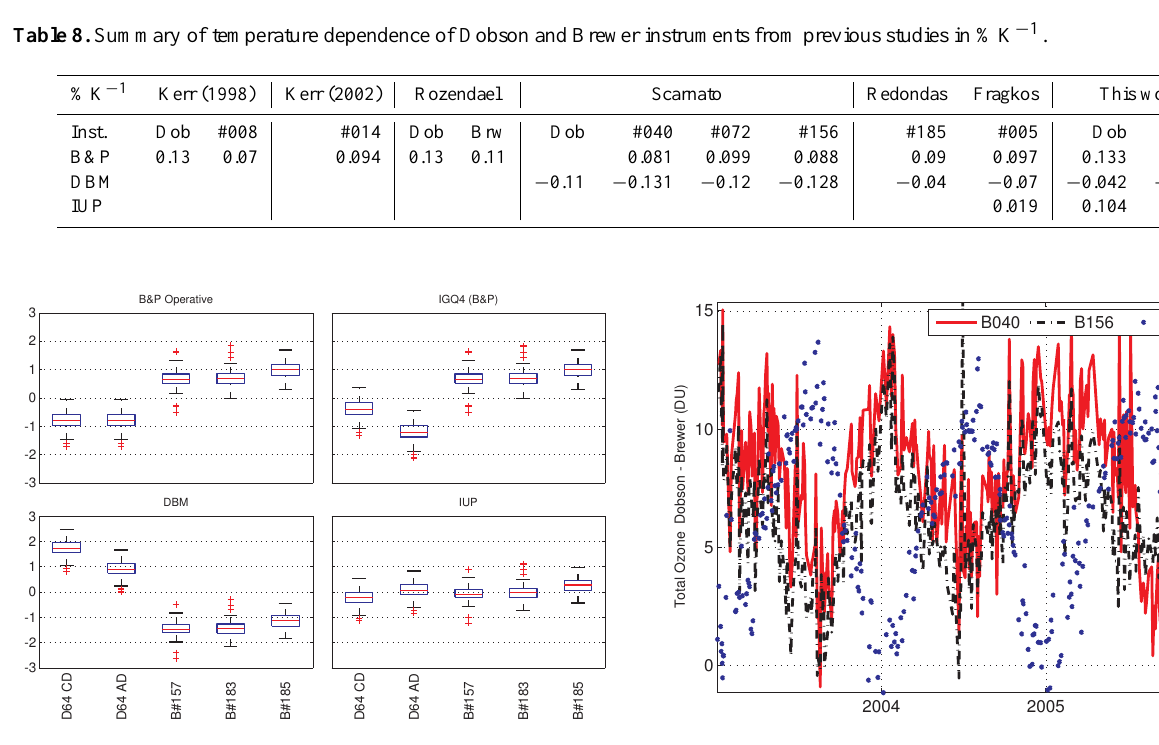
Fig. 8. Box plot of the percentage differences versus the mean of Dobson and Brewer instruments during the 2012 Langley plot cal- ibration campaign at Izaña Observatory for four cross sections: (1) Bass & Paur Operative (BOp); (2) Bass & Paur from quadratic co- efficients (IGQ4); (3) Daumont, Brion and Malicet (DBM); and (4) the University of Bremen (IUP). The first two boxes in each panel correspond to the Dobson pairs CD and AD and the last three to the Brewer triplet used at the RBCC-E. Table 9. Coefficients used to convert the ozone operational observa- tions of Dobson and Brewer instruments to evaluated cross sections.